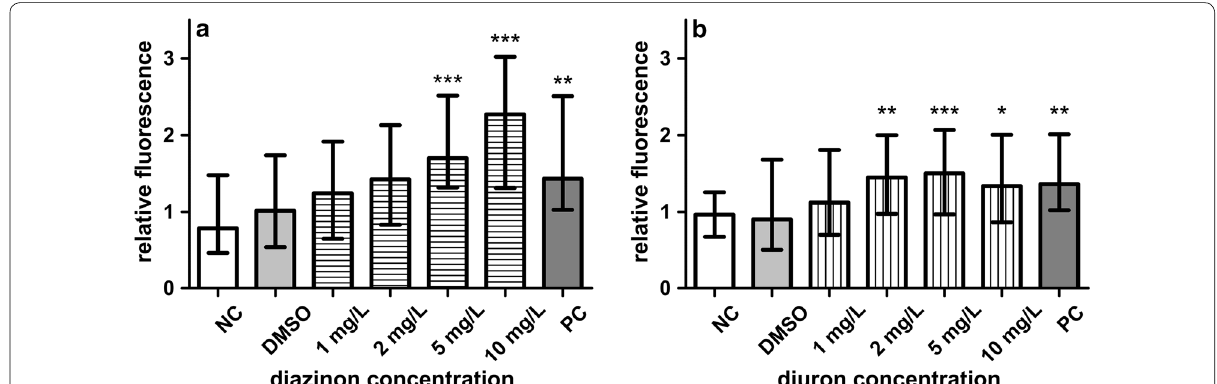
Fig. 1 Fluorescence measured in zebrafish larvae (96 hpf) exposed to diazinon ( a ) and diuron ( b ) for 1 h and incubated with CellTracker ™ Green CMFDA (40 min) for GSH detection. NC: negative control; DMSO: solvent control, 0.1% DMSO; PC: positive control ( tert ‑BHP). Bars represent medians with interquartile range of six repeated experiments (12 larvae per condition in each repetition). Analyses were made in comparison to the DMSO solvent control condition and significant differences are labeled with * p < 0.05, ** p < 0.01 and *** p <